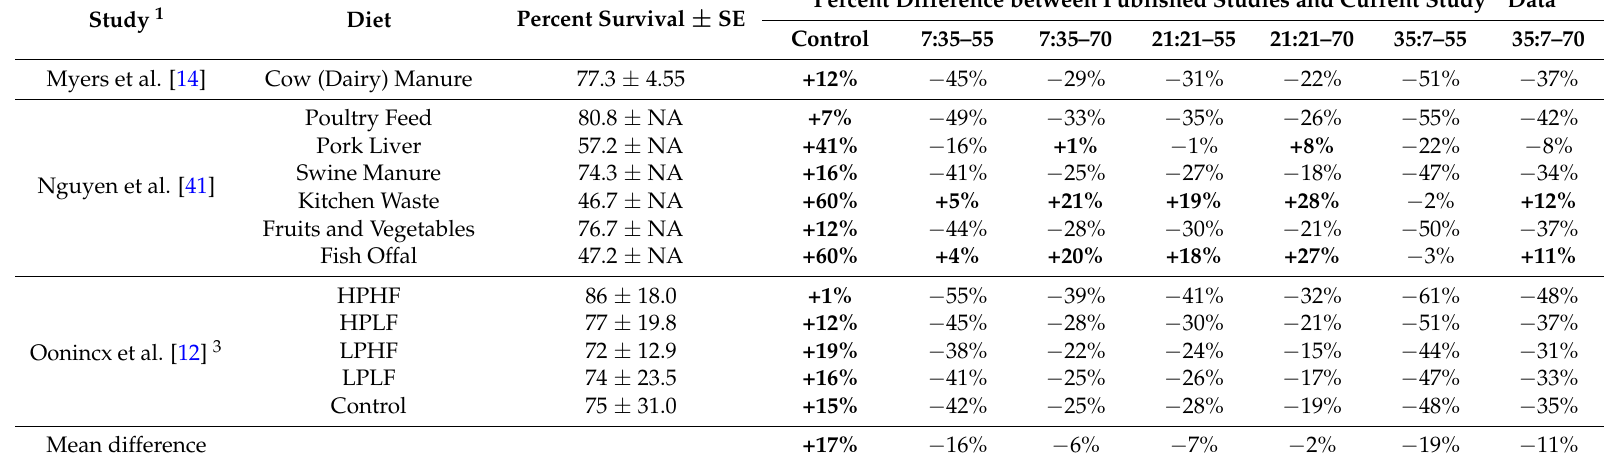
Table 4. Percent difference in black soldier fly larval survival from three previous studies to data generated in the current